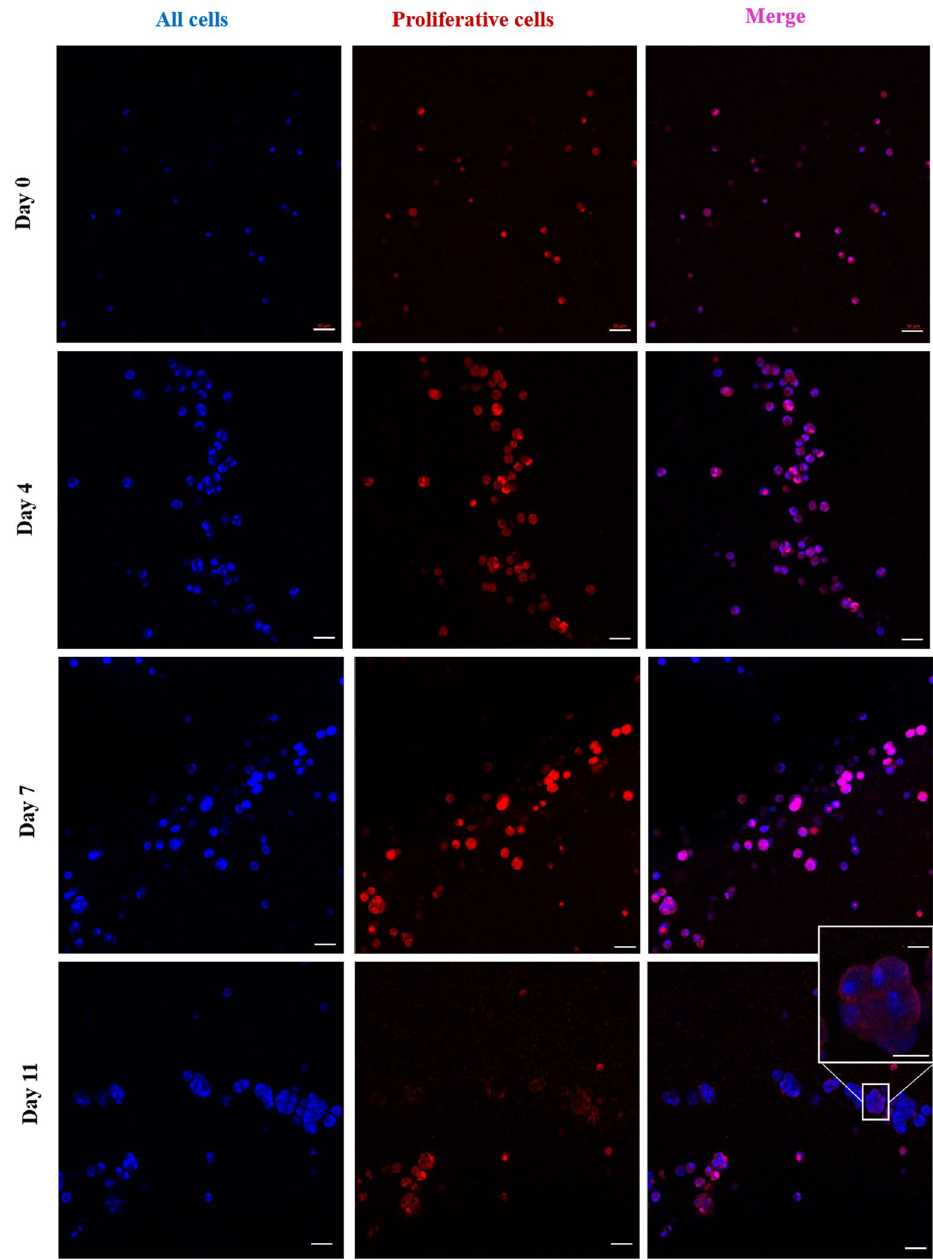
Figure 4. Ki-67 staining of encapsulated MDA-MB-231 cells within 3D bioprinted constructs. Cells were stained using anti-Ki-67 antibodies visualized with Alexa Fluor 546, and Hoechst 33,342 (red color represents cells positive to ki-67; blue color represents all cells). Cells were imaged using the laser scanning confocal microscope. Scale bar, 50 μm (enlarged image, scale bar, 30